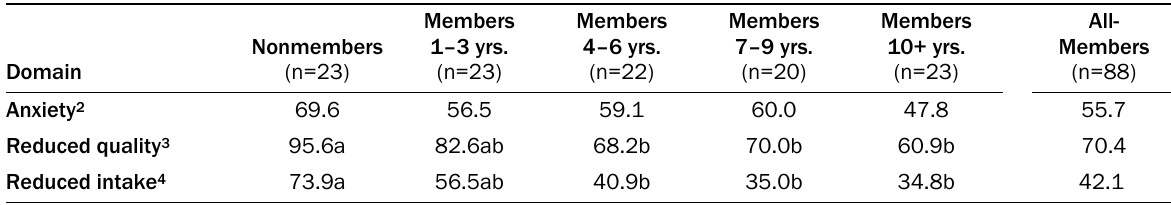
Table 8. Prevalence of Food Insecurity in Three Domains, by Dairy Group Membership Duration (% of households) 1